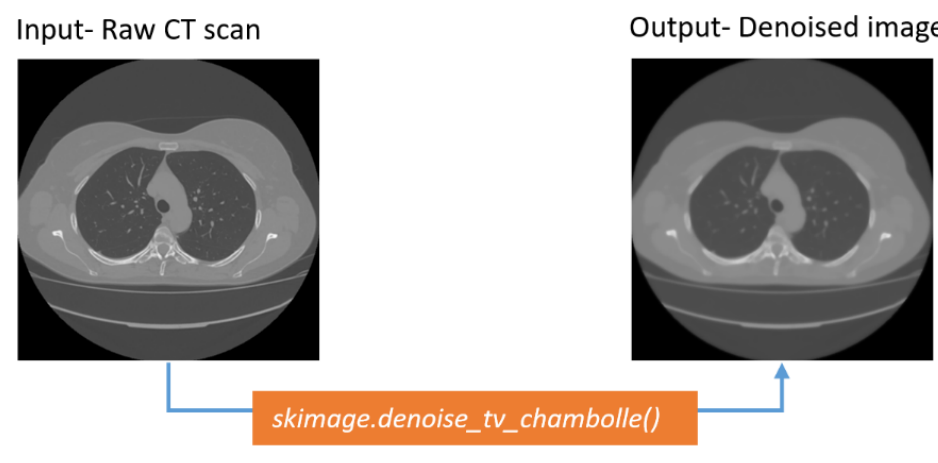
Figure 10. Output of TV denoising algorithm.